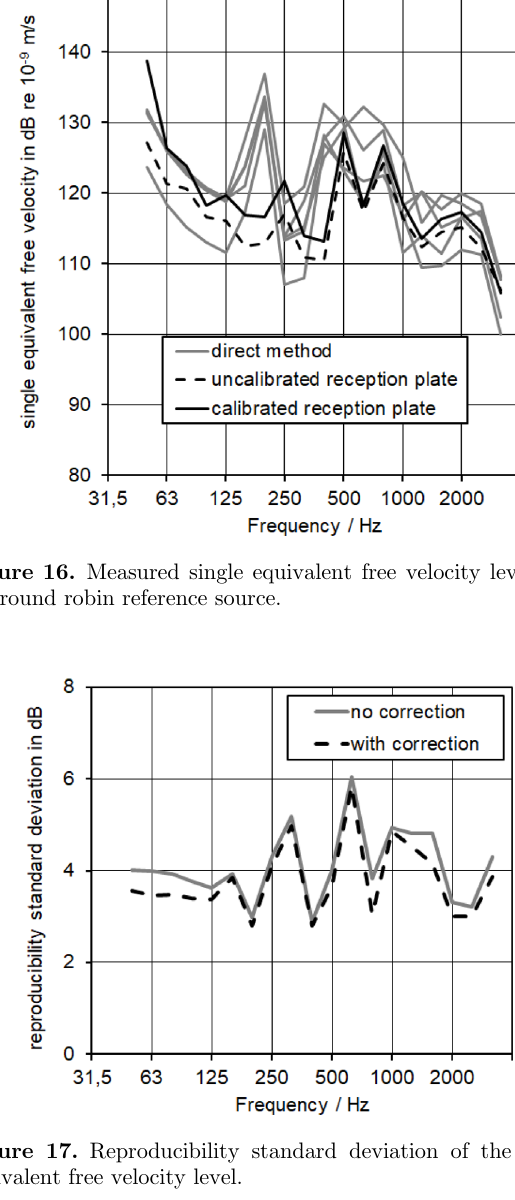
Figure 19. Measured single equivalent source mobility magni- tude levels for the round robin reference